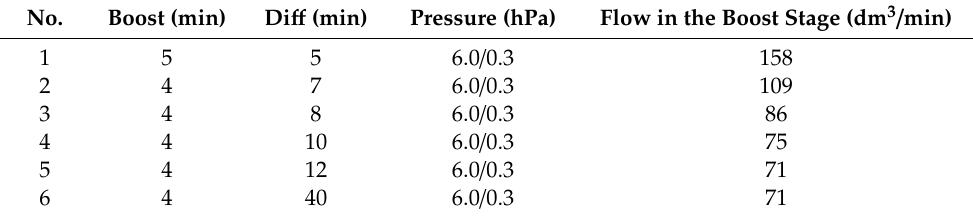
Table 1. Organization of the low-pressure carburizing process including carburizing mixture flow.